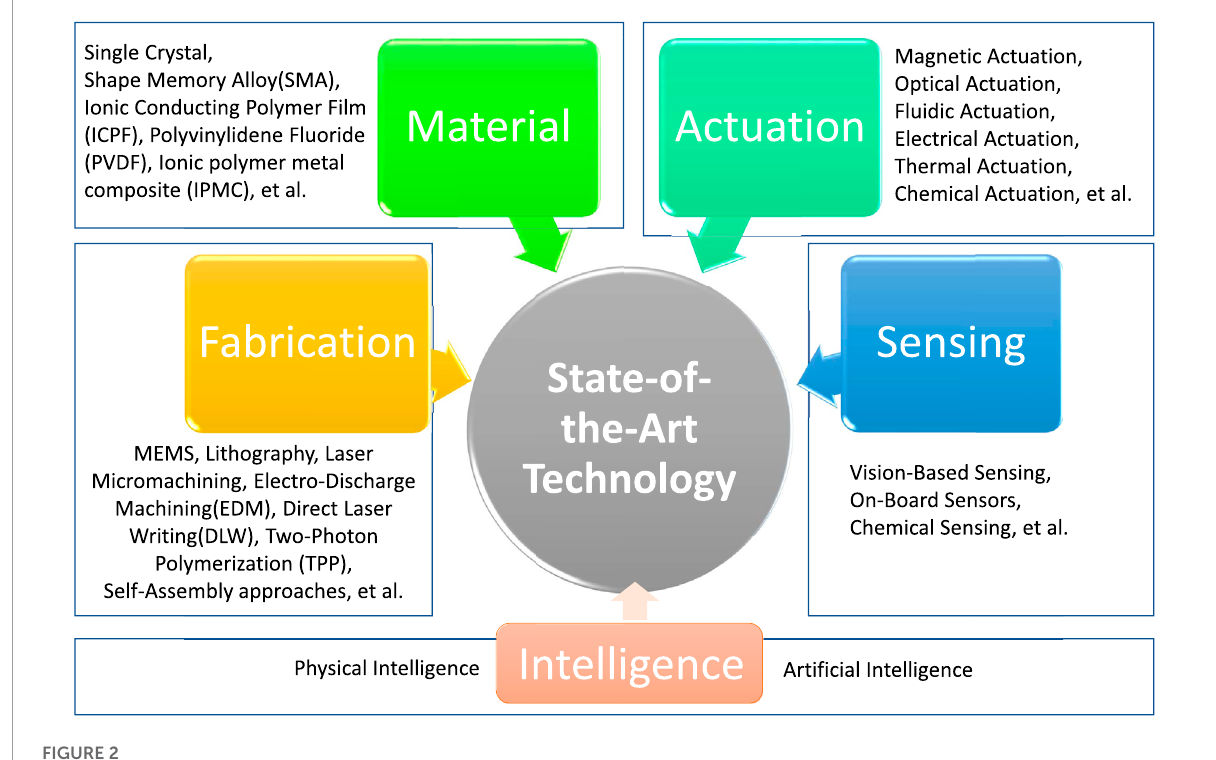
FIGURE 2 Technologies required for the development of medical